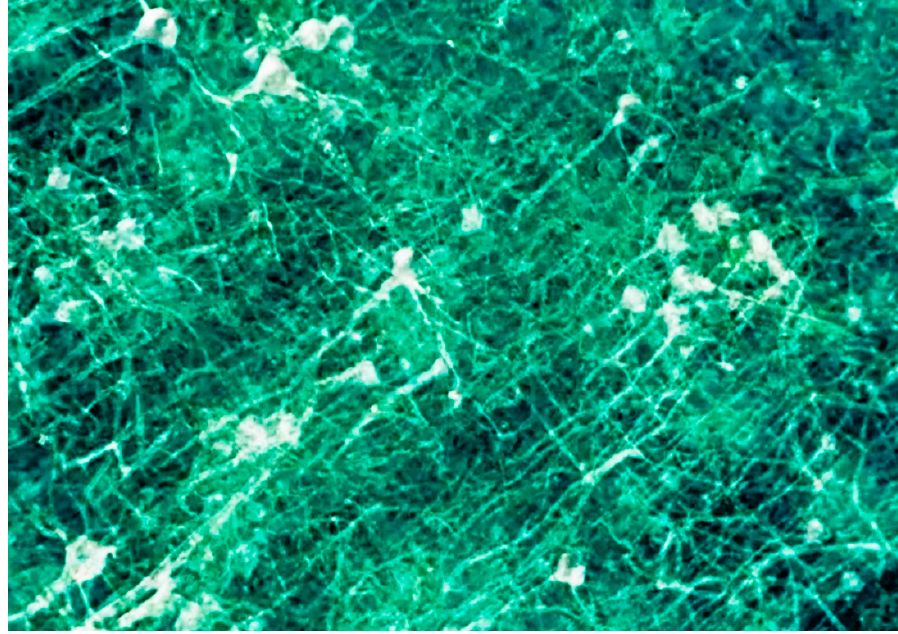
Figure 28. Neuron network specimen, one of the first coherence-based radiography results obtained under the SYNAPSE program [10].